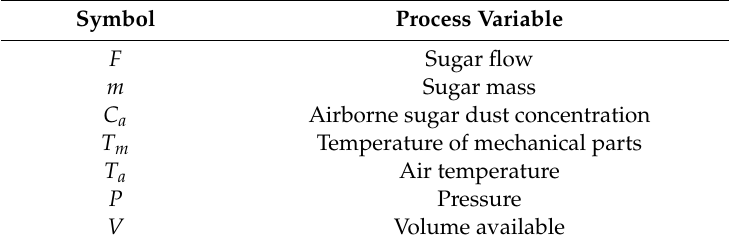
Table 7. Process variables analyzed in the ROA Plus–ISD